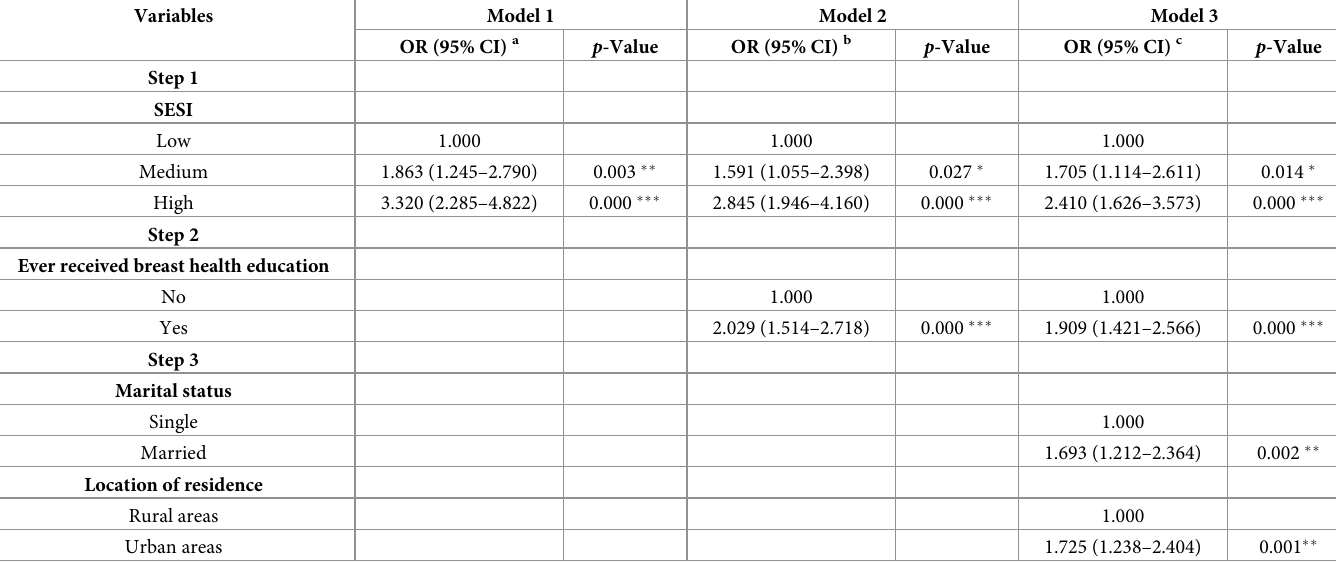
Table 5. Multivariate logistic regressions of CBE practice by SES index (n =